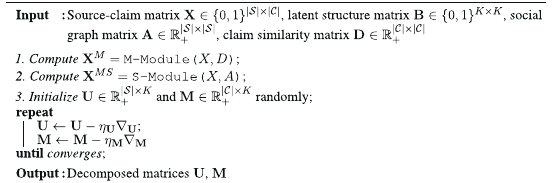
Algorithm 1. : Belief Structured Matrix Factorization